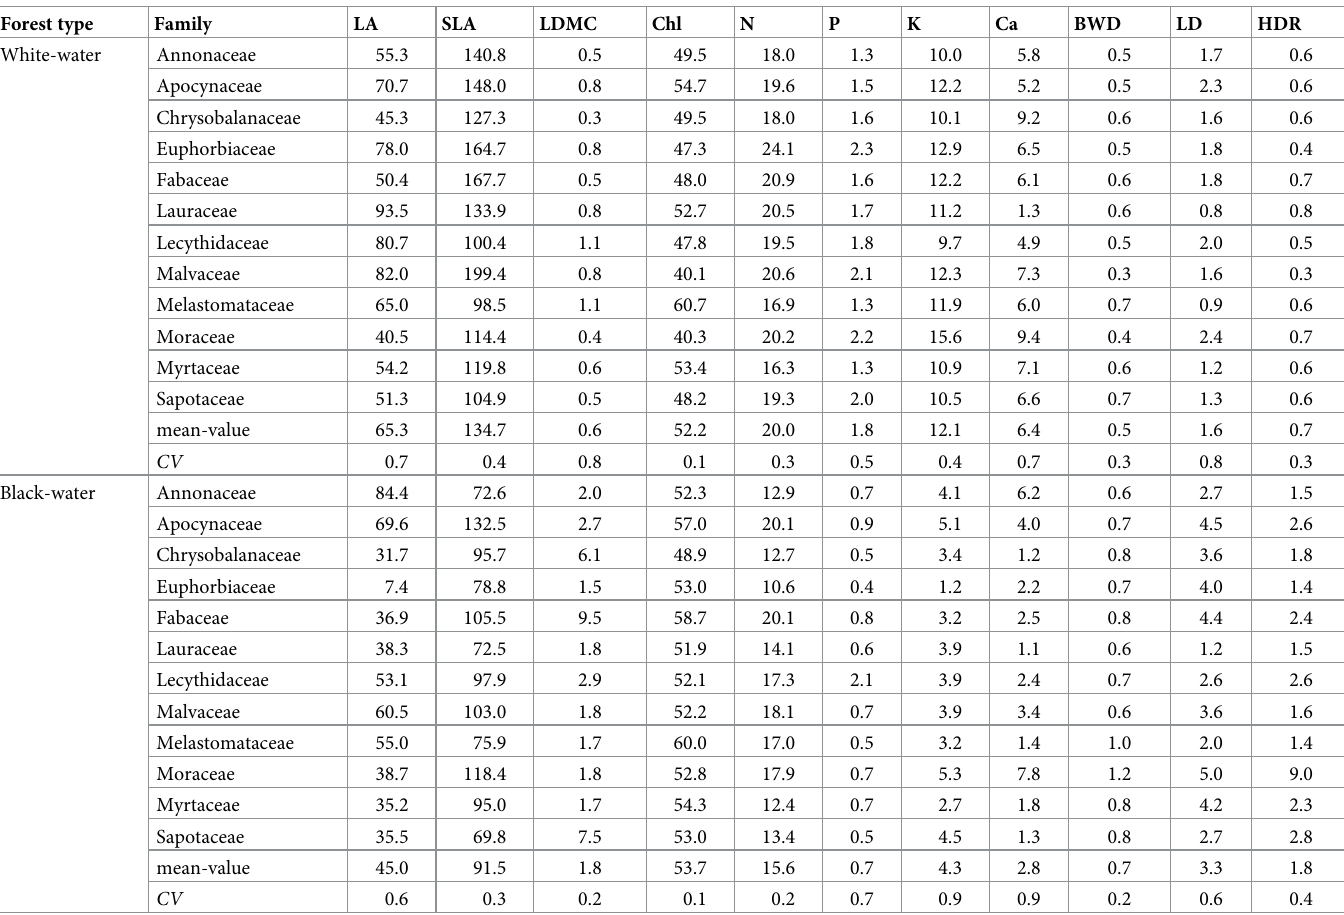
Table 4. Mean values of 11 functional traits of twelve families in white-water and black-water forests. The columns indicate trait mean values per family: leaf area (LA), specific leaf area (SLA), leaf dry matter content (LDMC), leaf nitrogen (N), leaf phosphorus (P), leaf potassium (K), leaf calcium (Ca), branch-wood density (BWD), lenticel density (LD), height:diameter ratio (HDR). Trait mean values are based on 5 individuals per family and coefficient of variation ( CV ) is based on all 54 genera per forest type (see Table 2 for trait units). Forest type Family